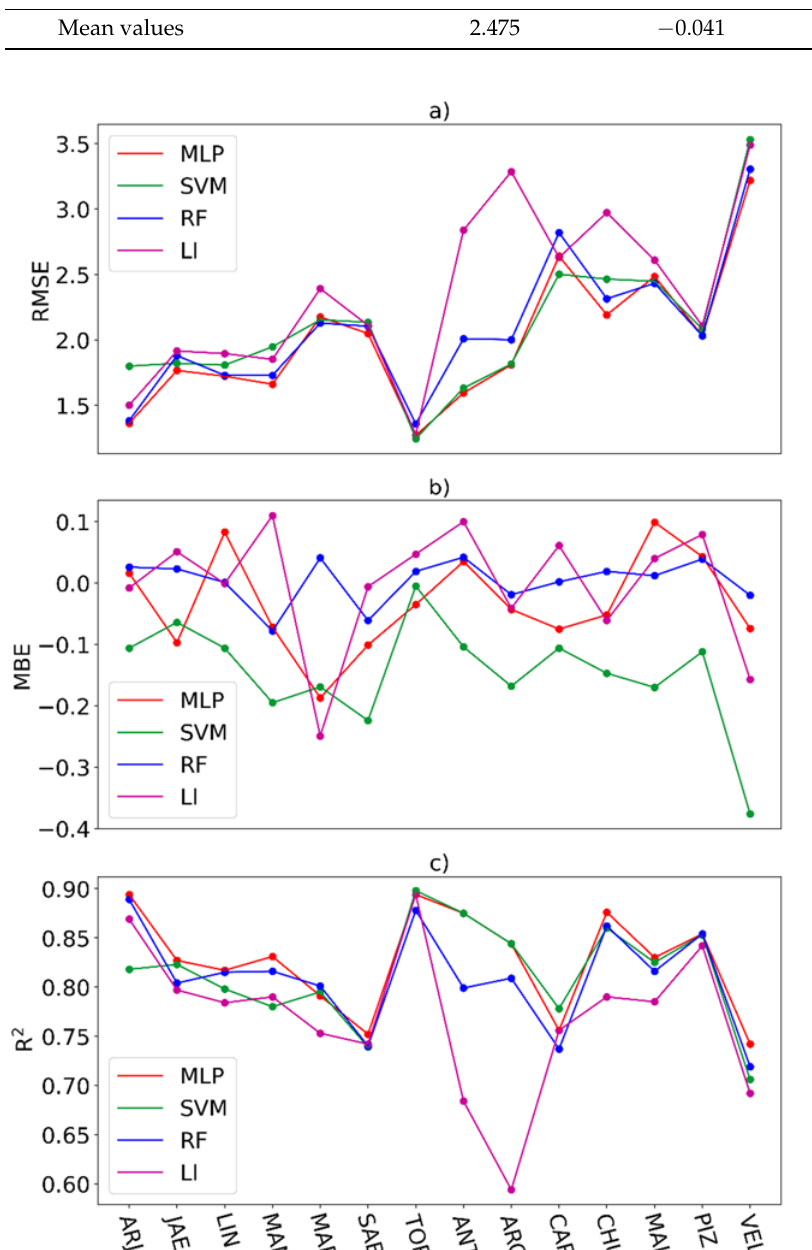
Figure 5. RMSE ( a ), MBE ( b ), and R 2 ( c ) values from testing dataset for all stations and models (MLP, SVM, RF, and LI), using only precipitation data from neighbor stations.